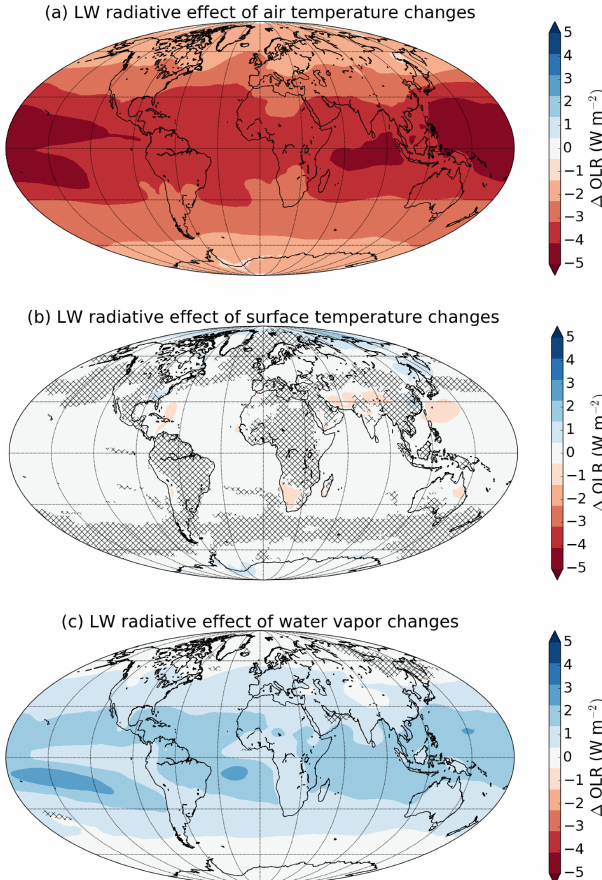
Figure 8. Multi-model mean change in OLR in G1 – piControl due to changes in atmospheric temperature (a) , surface tempera- ture (b) , and specific humidity (c) , calculated using radiative kernels (Shell et al., 2008). Hatching indicates areas where fewer than 9 of 11 models agree on the sign of the